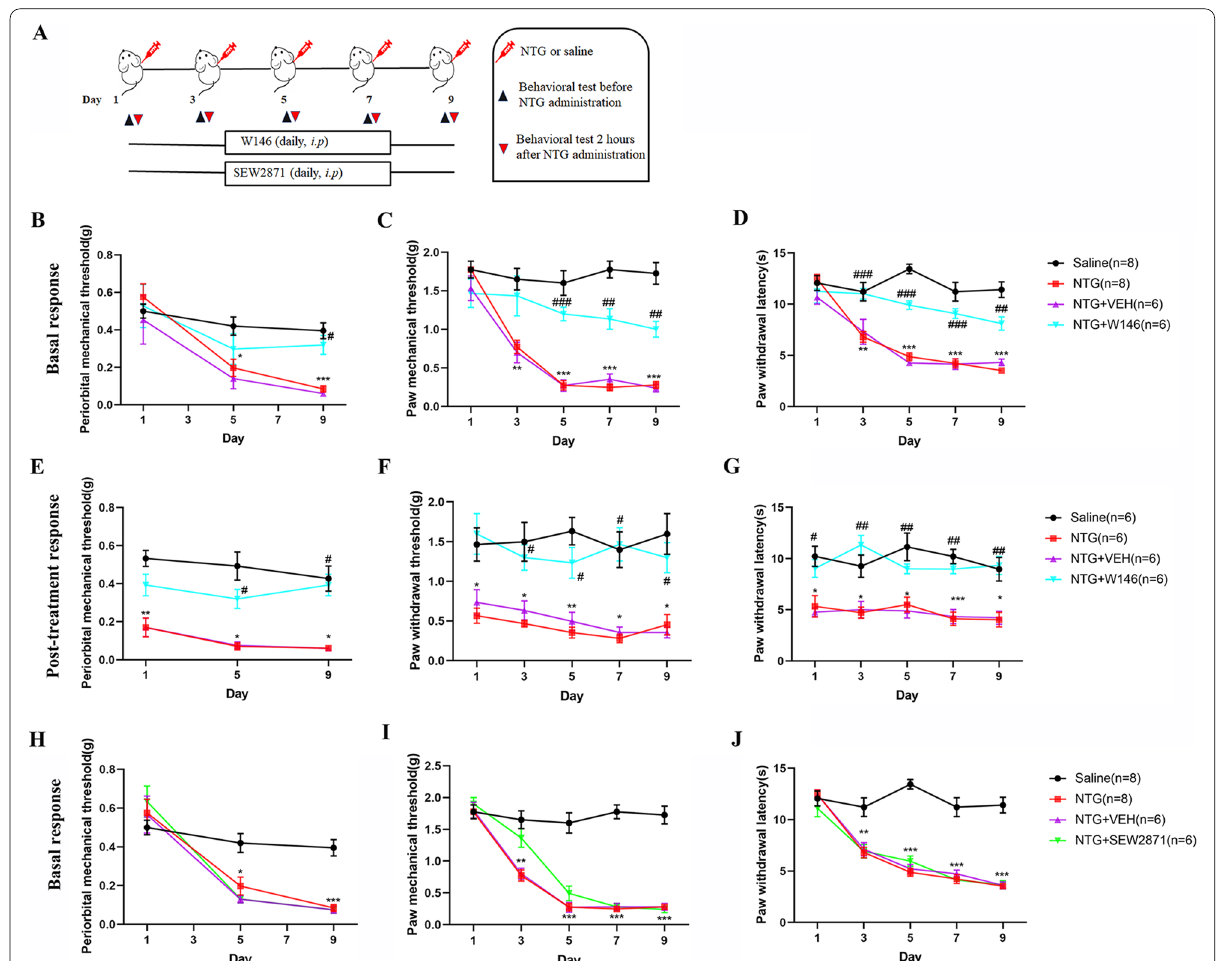
Fig. 2 Blocking S1PR1 signaling attenuated mechanical or thermal hyperalgesia caused by chronic NTG administration. A Timeline of drug administration and behavioral testing. B‑C Repeated daily injection of W146 before NTG could prevented basal mechanical and thermal hyperalgesia of periorbital (B) and hindpaw (C, D) . E–G post—treatment responses were assessed 2 h after NTG administration. W146 could attenuate NTG-triggered acute hyperalgesia. Two-way ANOVA and Bonferroni post hoc test analysis; * p < 0.05, ** p < 0.01 and *** p < 0.001 compared with the Saline group; # p < 0.05, ## p < 0.01 and ### p < 0.001 compared with the NTG group. H‑J Repeated daily injection of SEW2871 (a S1PR1 agonist) before NTG did not prevent basal hyperalgesia of periorbital (H) and hindpaw (I‑J) . Two-way ANOVA and Bonferroni post hoc test analysis; * p < 0.05, ** p < 0.01 and *** p < 0.001 compared with the Saline